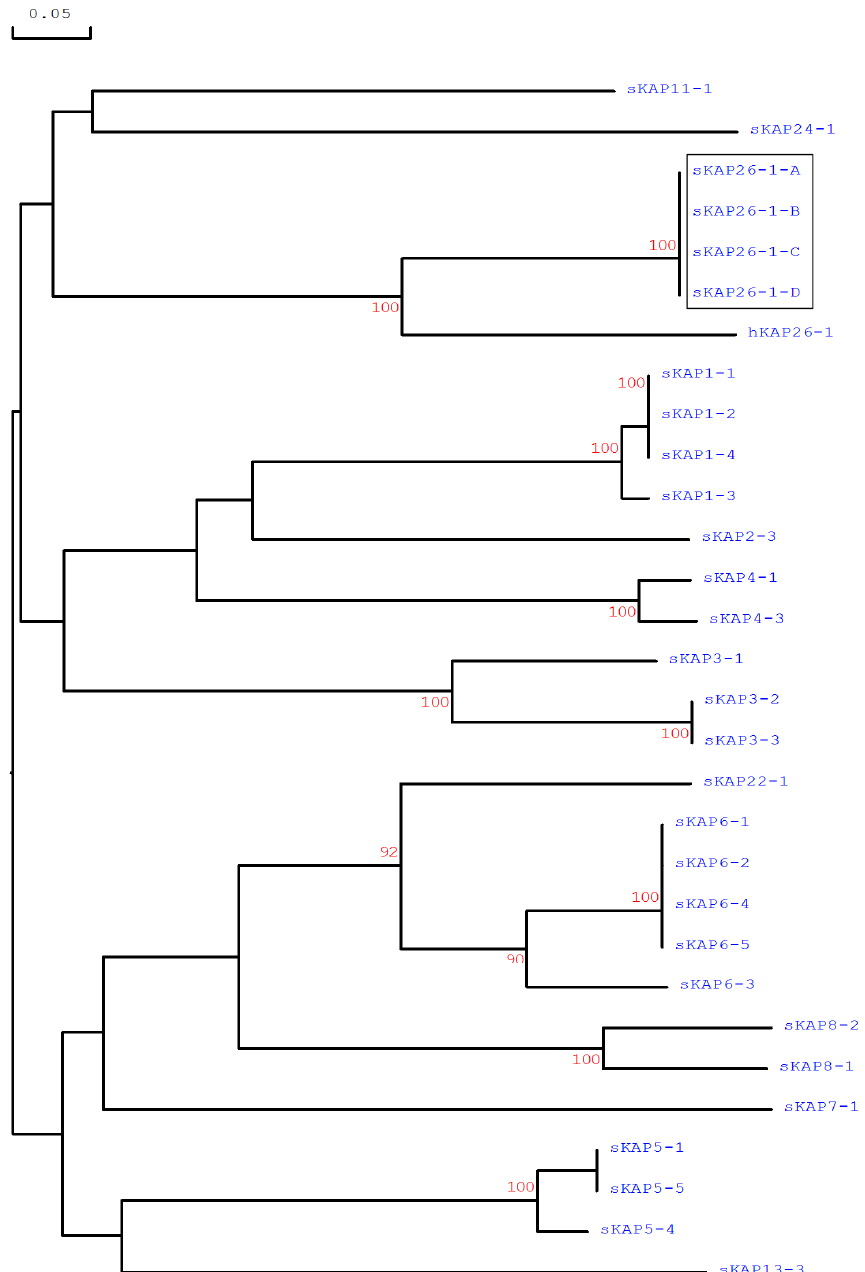
Figure 3. Phylogenetic tree of all the ovine KAPs identified to date together with human KAP26-1. The tree was constructed using the predicted amino acid sequences derived from the genes. The ovine KAPs are indicated with the prefix “s” and the human KAPs have the prefix “h”. The newly identified ovine KAP26-1 sequences are shown in a box. The numbers at the forks indicate the bootstrap confidence values and only those equal to, or higher than 90%, are shown. The GenBank accession numbers for the human KAP26-1 is AM941740.1. The GenBank accession numbers for the sheep KAPs are X01610, HQ897973, X02925, X01610, U60024, M21099, M21100, M21103, X73462, EU239778, X55294, X73434, X73435, M95719, KT725827, KT725833, KT725838, KT725841, X05638, X05639, sKAP1-4, sKAP2-3, sKAP3-1, sKAP3-2, sKAP3-3, sKAP4-1, sKAP4-3, sKAP5-1, sKAP5-4, sKAP5-5, sKAP6-1, sKAP6-2, sKAP6-3, sKAP6-4, sKAP6-5, sKAP7-1, sKAP8-1, sKAP8-2, sKAP11-1, sKAP13-3, sKAP22-1, and sKAP24-1,